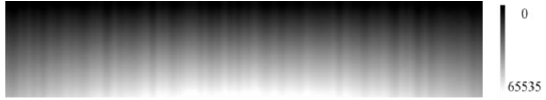
Figure 5. Simulated verification image (100 samples × 20 lines) with 20 times measurements.